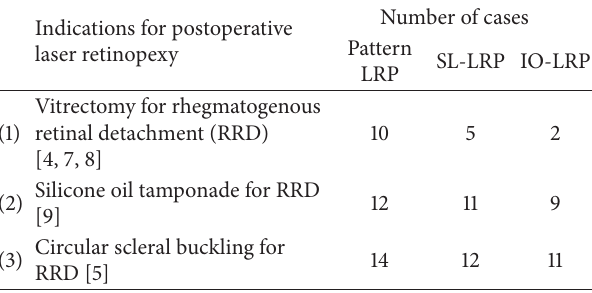
Table 1: Indications for postoperative laser retinopexy (and propor- tion of patients included in the